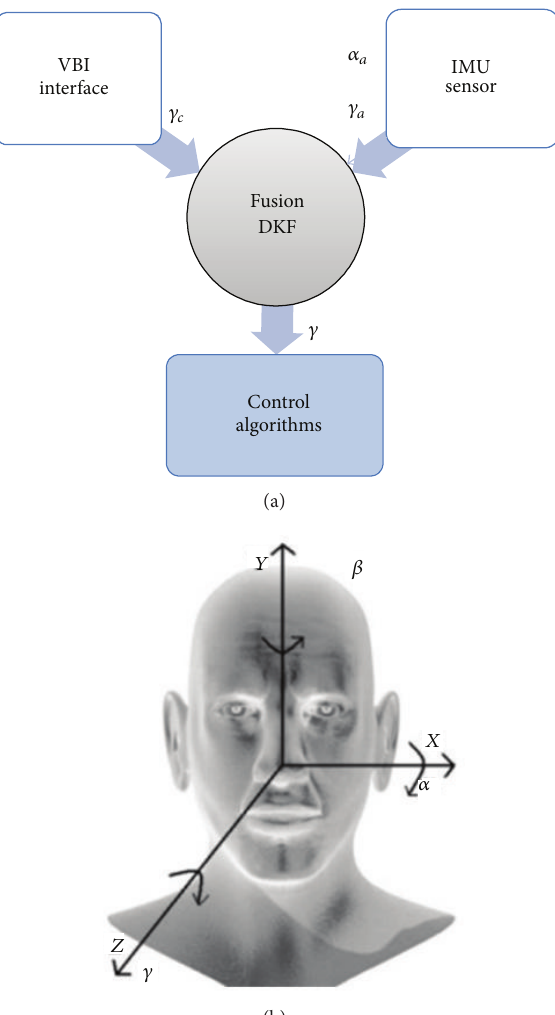
Figure 1: (a) System overview. The DKF fuses the head orientation angles obtained through VBI ( 𝛾 𝑐 ) and the IMU sensor ( 𝛾 𝑎 ). The estimated angle 𝛾 is used in the control algorithms. (b) Reference framework associated with the user’s head and rotation angles of the head in the 3D space related to the coordinate